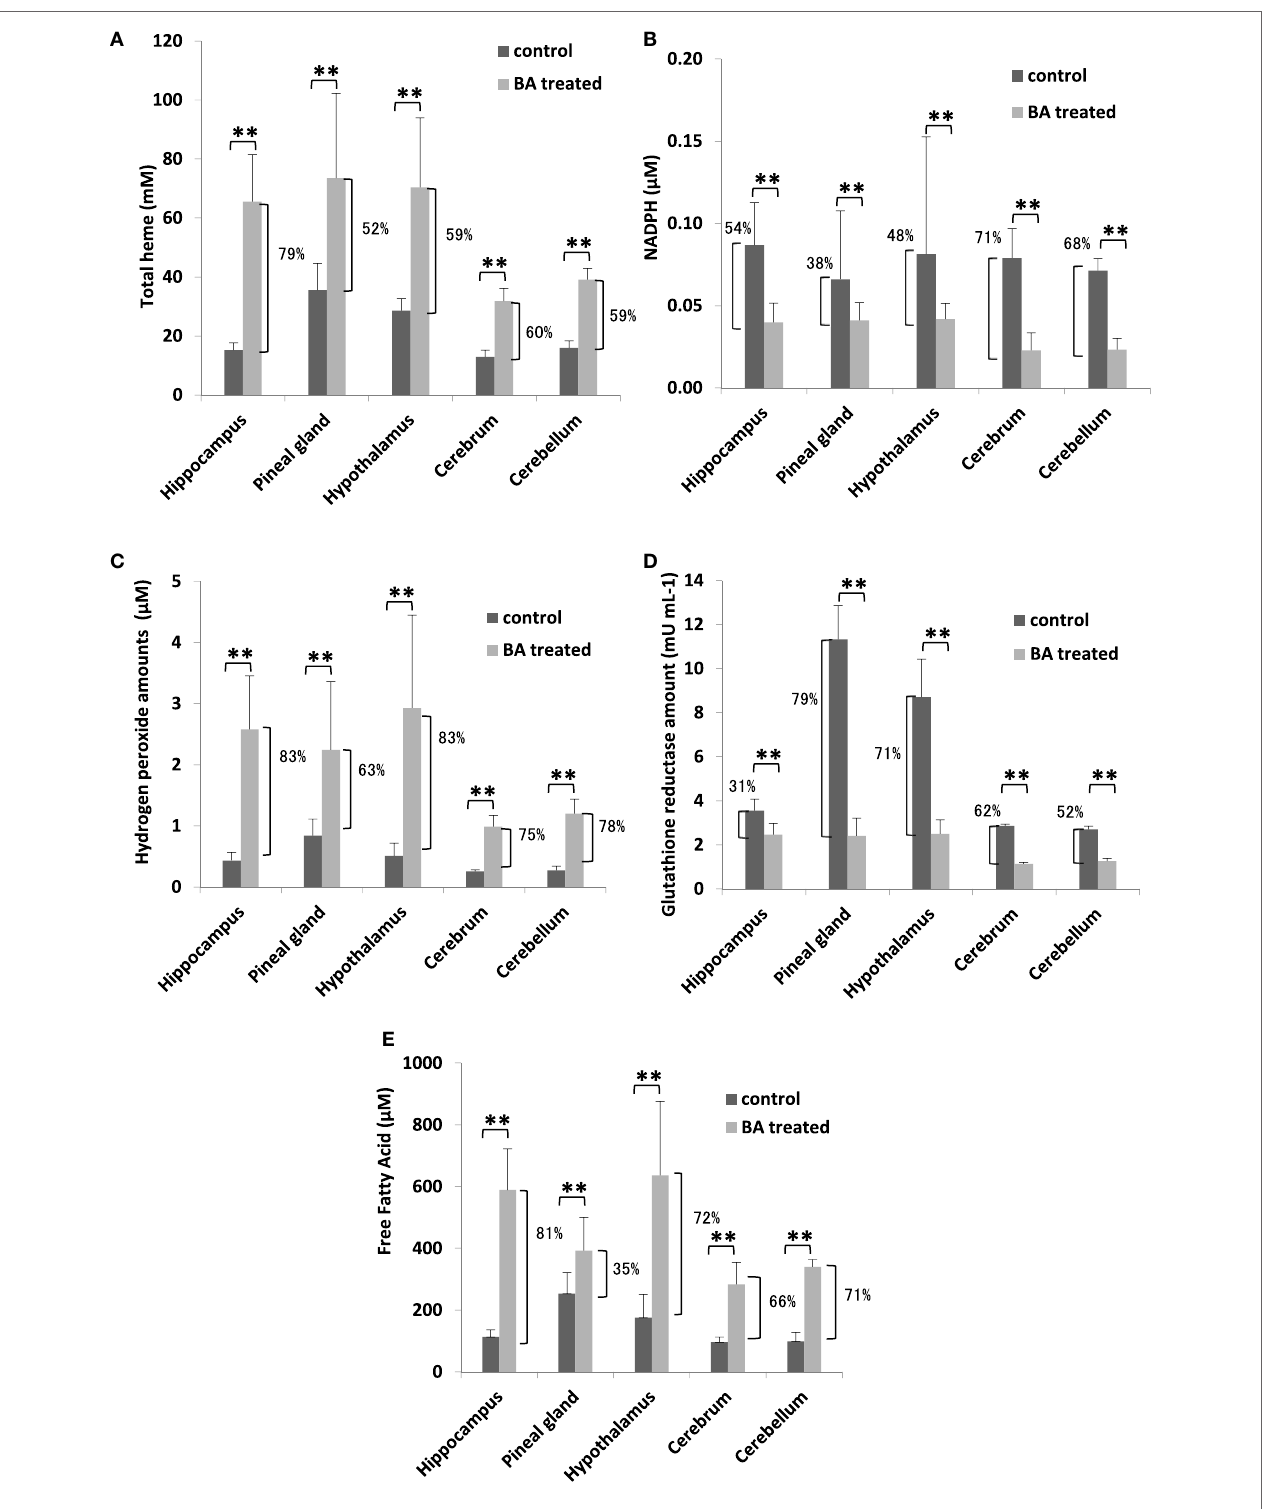
FigUre 4 | Gingival periodontal disease level-butyric acid (BA) induces oxidative stress in different regions of the brain organ. Quantification of brain (a) total heme, (B) NADPH, (c) hydrogen peroxide, (D) glutathione reductase, and (e) free fatty acid amounts are indicated. Results shown are mean ± SE utilizing independent brain samples (hippocampus, pineal gland, hypothalamus, cerebrum, and cerebellum) of 10-week-old Wistar male rats ( n = 6). Control and BA-treated (12 h post-treatment) rats were used. Statistical analyses were performed using Anderson–Darling normality test and, if passed ( p > 0.05), Student’s t -test (** p < 0.01). Percent difference between control and BA-treated rats are